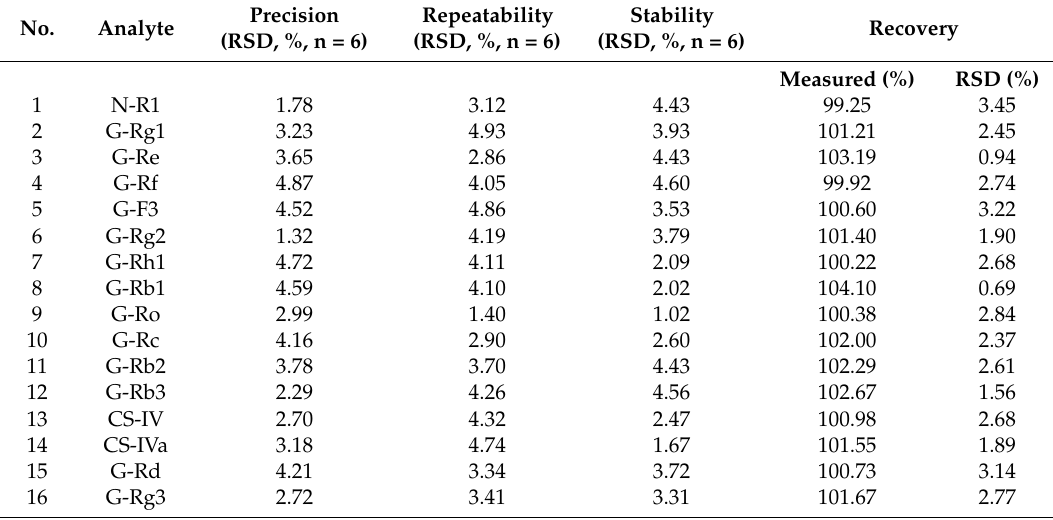
Table 5. The precision, repeatability, stability, and recovery of the 16